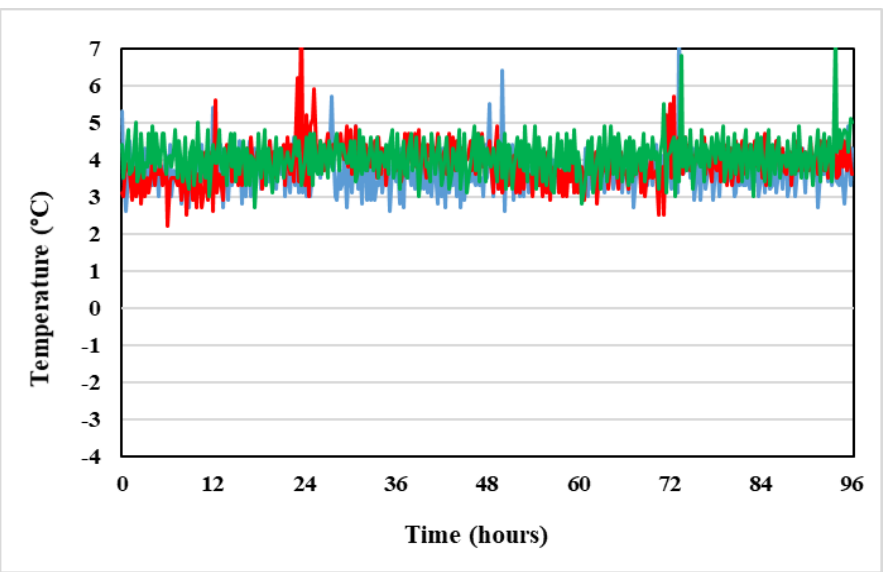
Figure 12. Trend of the temperature inside two refrigerators where the three Vidaza ® lots were placed.